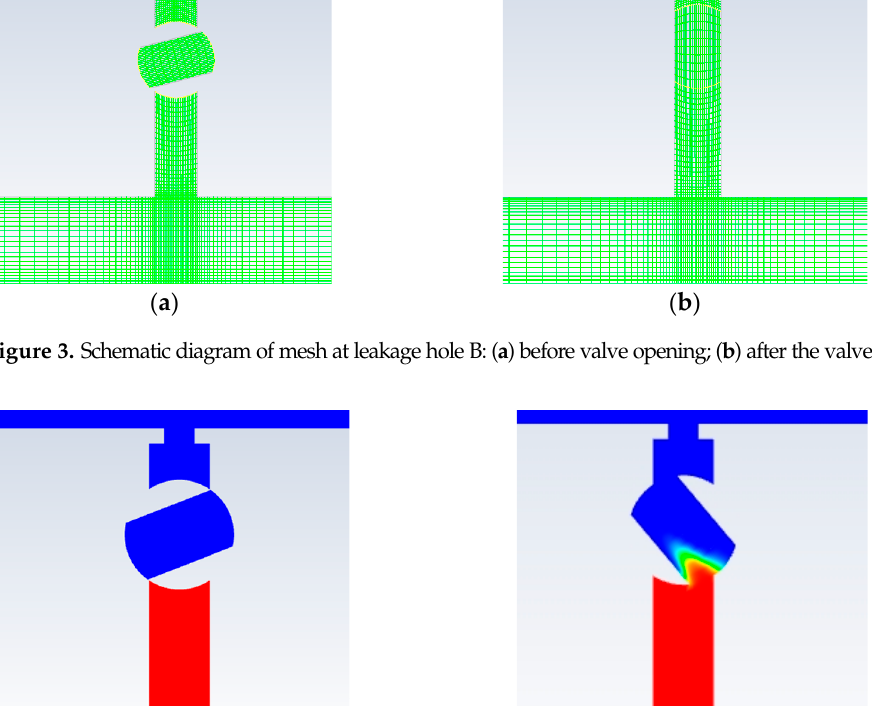
Figure 2. Schematic diagram of the leakage hole: ( a ) leakage hole A; ( b ) leakage hole B.